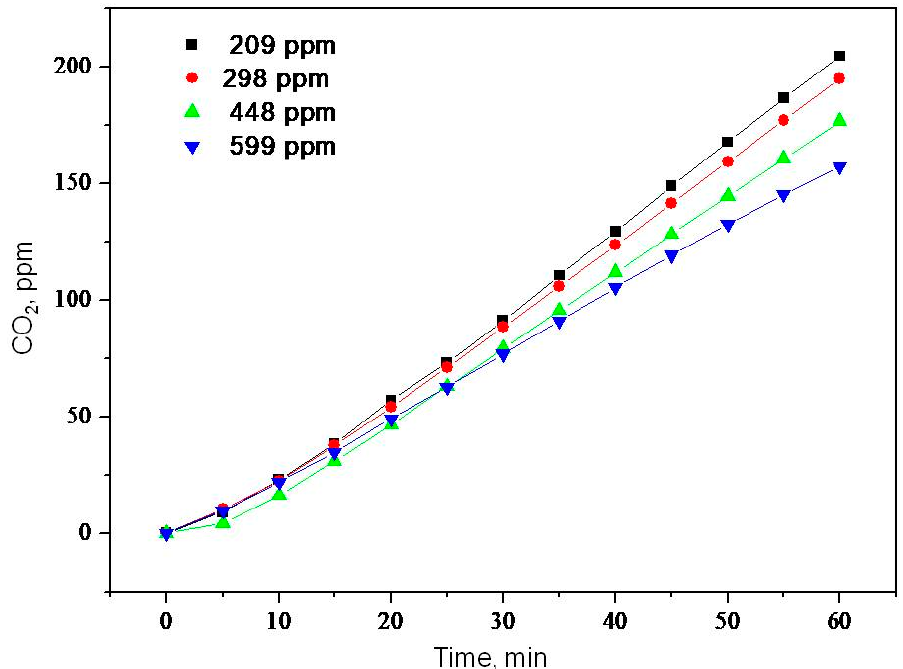
Figure 4. Photocatalytic degradation of acetone (as CO 2 produced) determined at different initial concentrations of the substrate. TiO 2 (P25, Degussa) commercial powder is used. The experimental error is ≤ 10%.